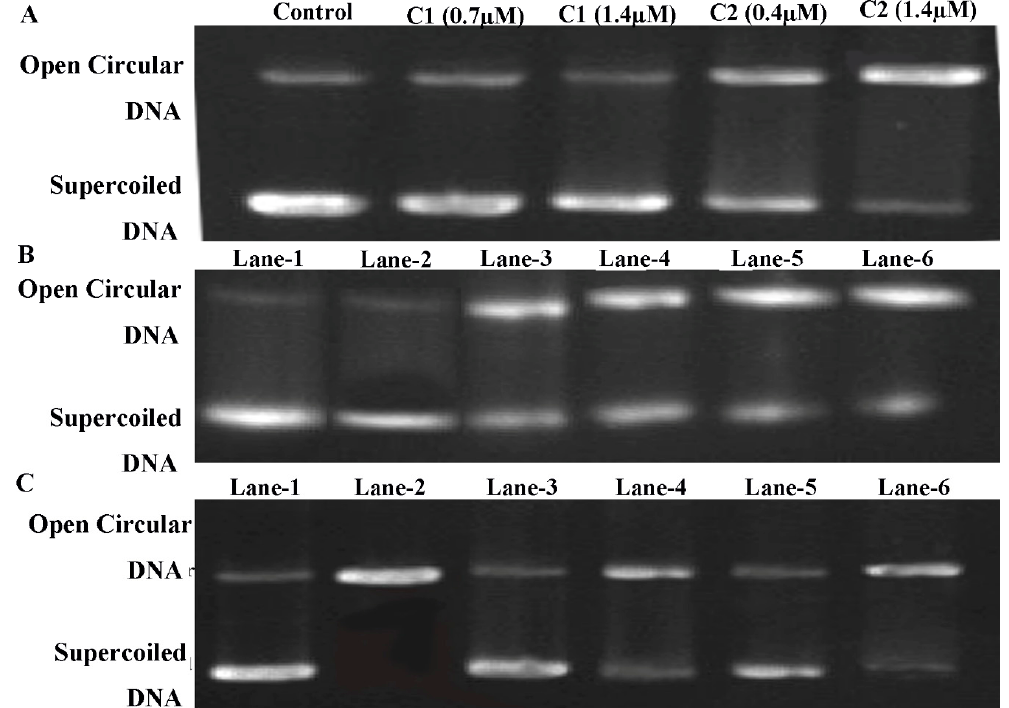
Figure 10. ( A ) Cleavage of pBR322 plasmid DNA by C1 and C2, using agarose gel electrophoresis. ( B ) Cleavage of pBR322 plasmid DNA by C1 and C2 in the presence of H 2 O 2 using agarose gel electrophoresis; lane 1: Plasmid DNA + H 2 O 2 ; lane 2: Plasmid DNA + H 2 O 2 + CuCl 2 ; lane 3: Plasmid DNA + H 2 O 2 + C1 (0.7 μ M); lane 4: Plasmid DNA + H 2 O 2 + C1 (1.4 μ M); lane 5: Plasmid DNA + H 2 O 2 + C2 (0.7 μ M); lane 6: Plasmid DNA + H 2 O 2 + C2 (1.4 μ M). C . Inhibition of topoisomerase-I activity; lane 1: Plasmid DNA; lane 2: Plasmid DNA + 1U topoisomerase I; lane 3: Plasmid DNA + 1U topoisomerase-I + C1 (0.7 μ M); lane 4: Plasmid + 1U topoisomerase-I + C (1.4 μ M); lane 5: Plasmid DNA + 1U topoisomerase-I + C2 (0.7 μ M); lane 6: Plasmid DNA + topoisomerase-I + C2 (1.4 μ M).